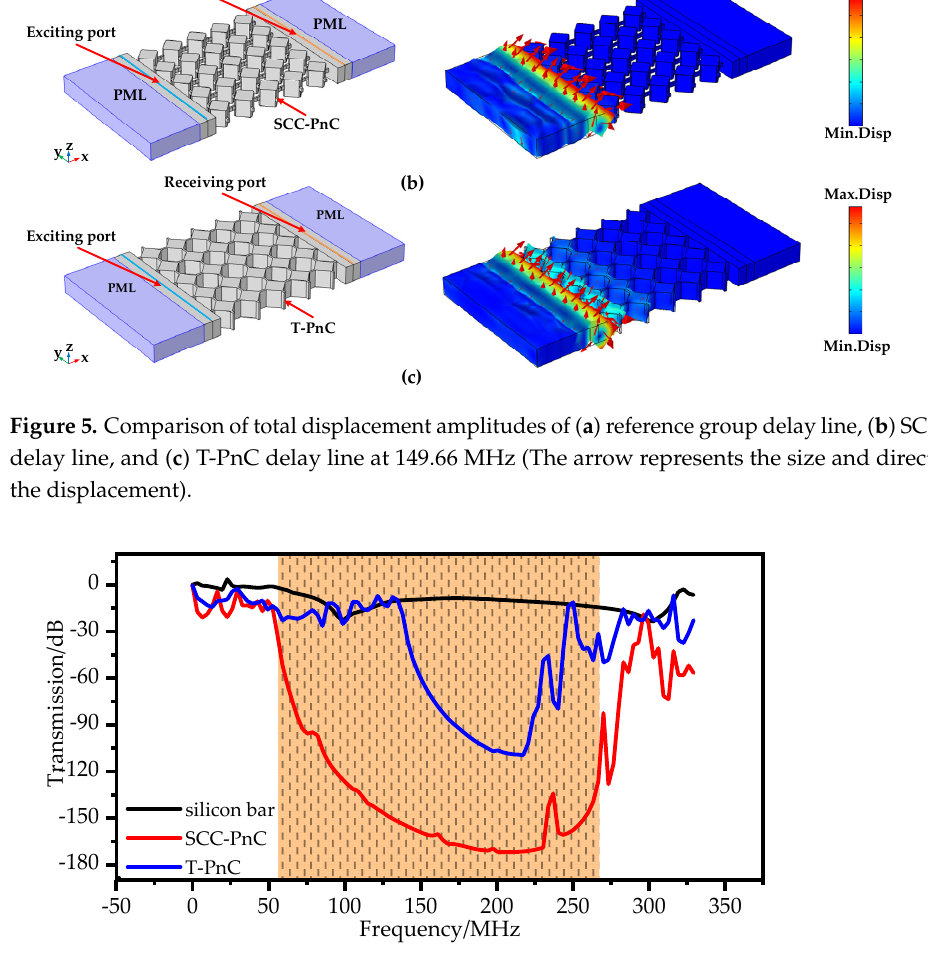
Figure 5. Comparison of total displacement amplitudes of ( a ) reference group delay line, ( b ) SCC ‐ PnC delay line, and ( c ) T ‐ PnC delay line at 149.66 MHz (The arrow represents the size and direction of the displacement).